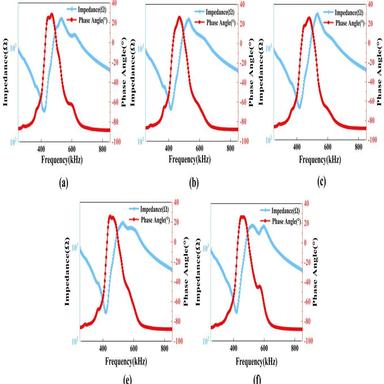
Impedance spectra of ultrasonic transducers with different pore sizes of MCE (a) 0.22 μm, (b) 0.45 μm, (c) 0.65 μm, (d) 0.8 μm, (e) 1.2 μm.